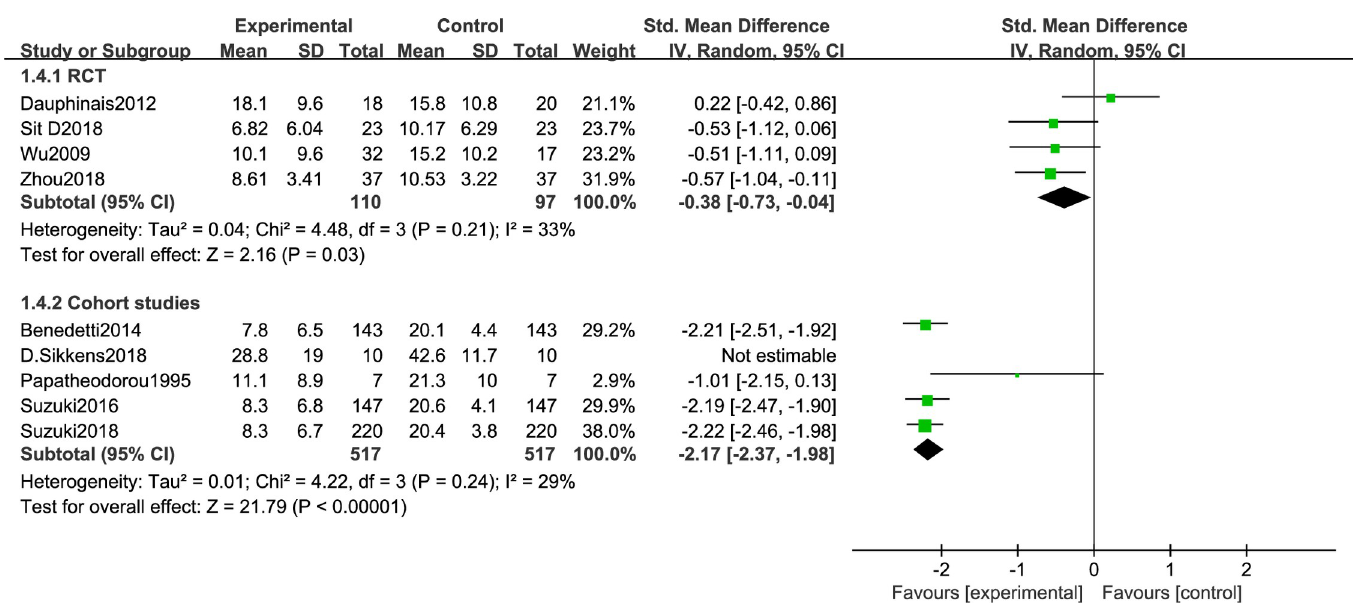
Fig 13. Forest plots with light intensities greater than